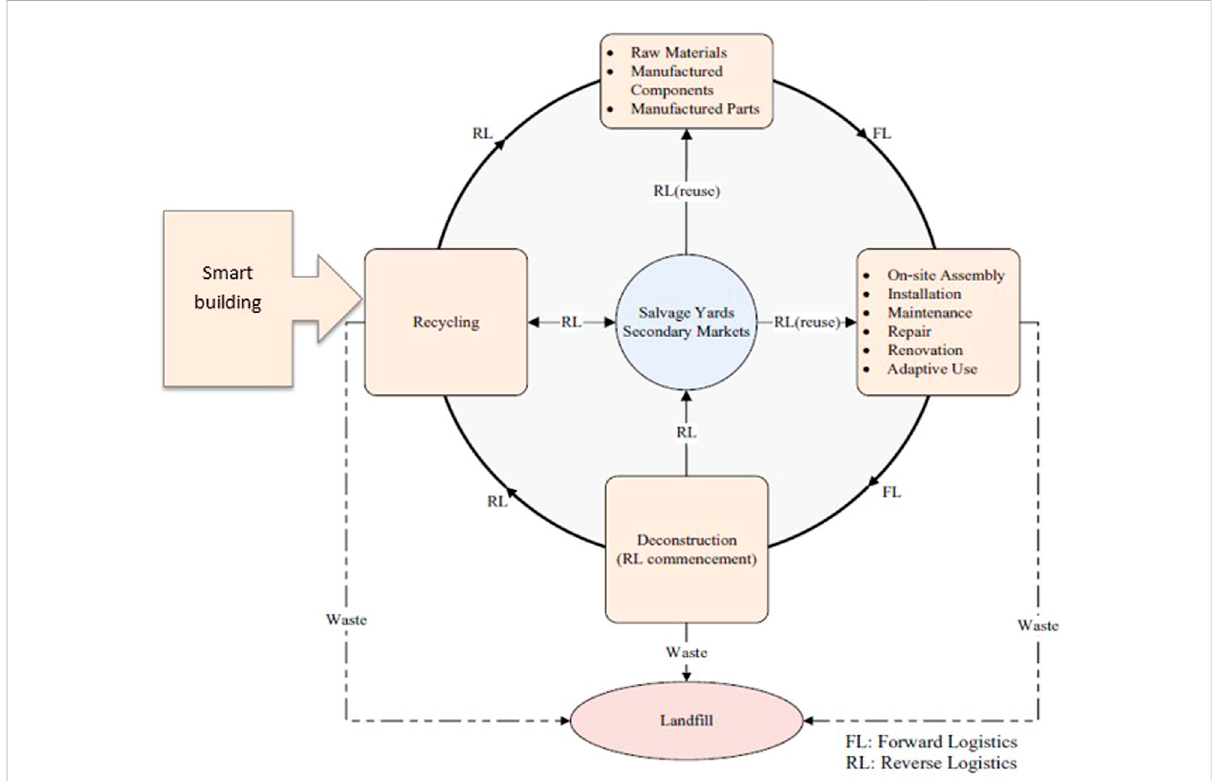
FIGURE 1 RL framework of construction (Fleischmann et al., 1997; Govindan and Bouzon, 2018; Correia et al.,